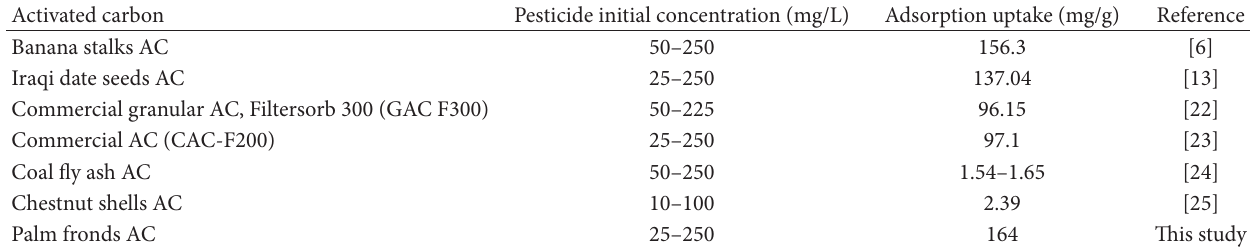
T 2: Comparison of the maximum adsorption uptake of carbofuran insecticide onto different type of activated